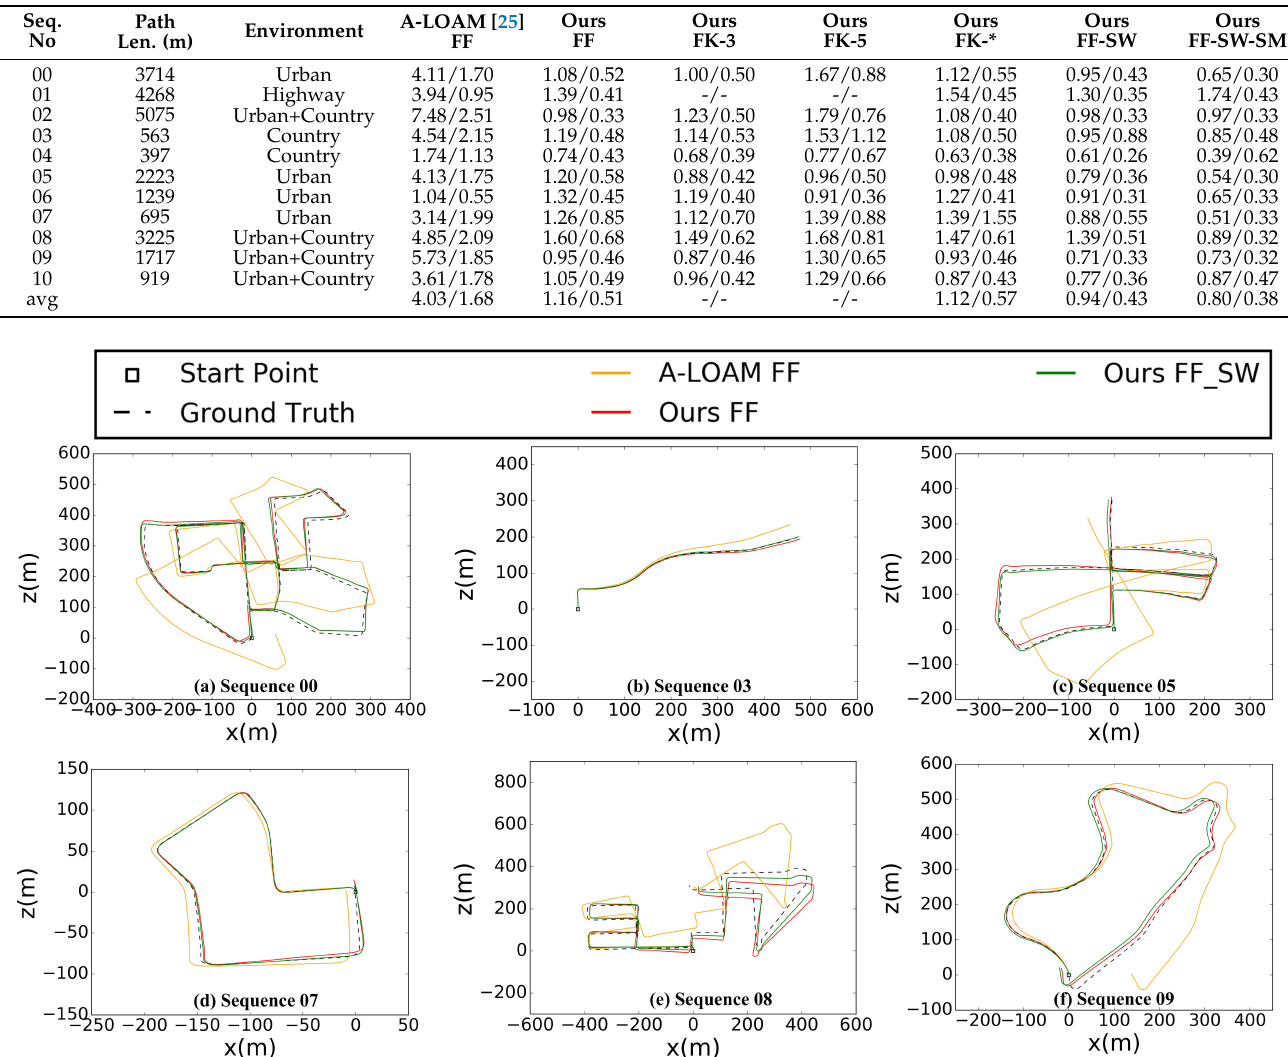
Table 4. Translation error [%]/rotation error [deg/100 m] comparison of the different direct visual odometry with ICP-based LiDAR odometry on the whole KITTI training dataset.